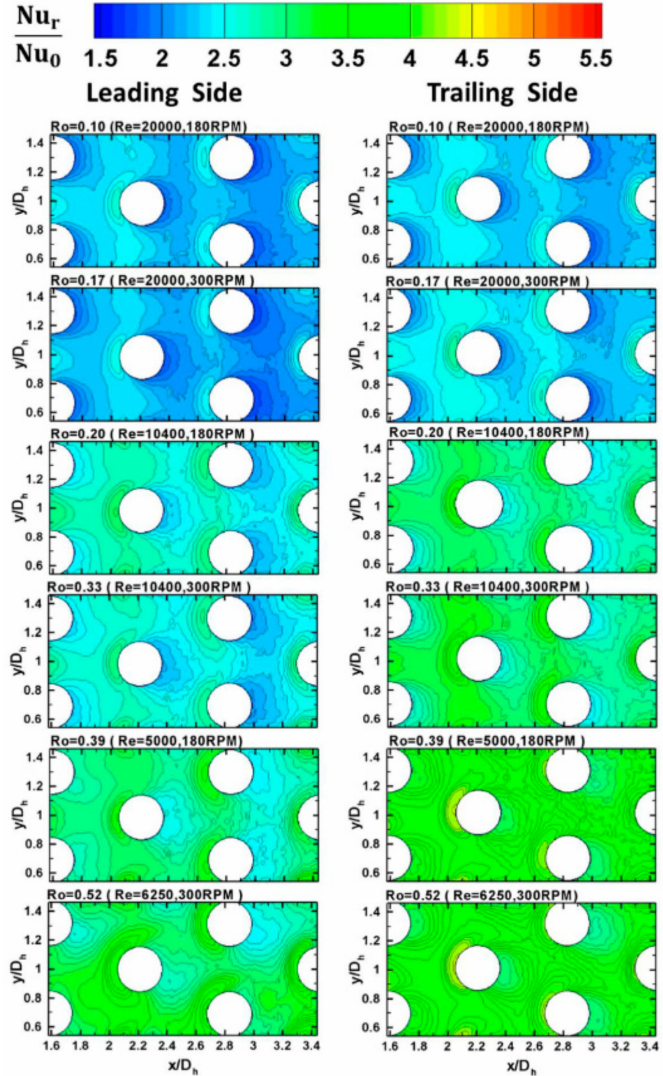
Figure 20. Local Nusselt number under rotation [46]. Reprint with permission from Elsevier (order number